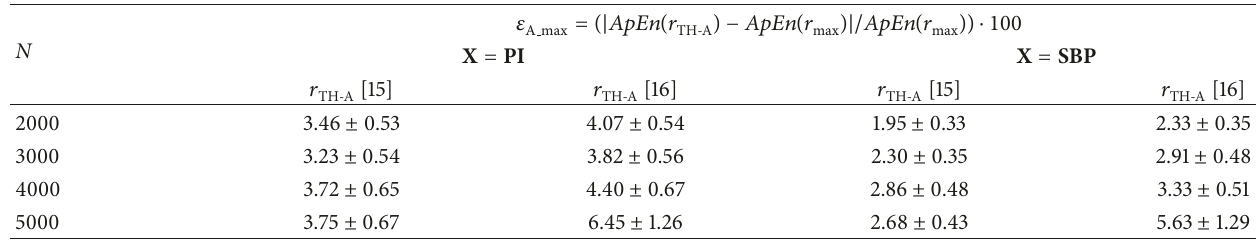
Table 2: Relative error of XApEn ( 𝑟